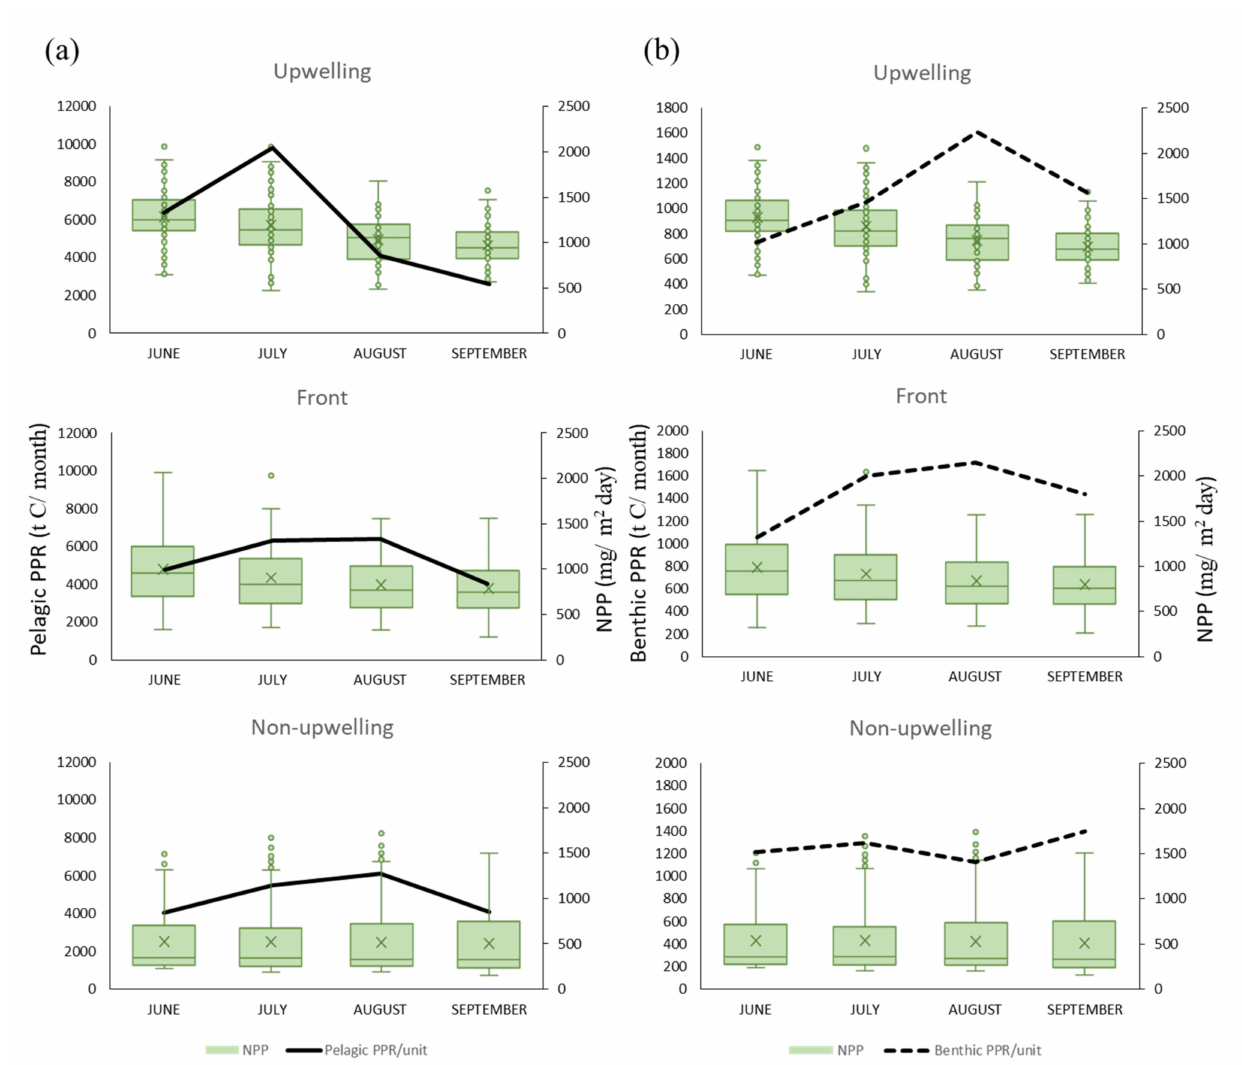
Figure 9. Effects of net primary production (NPP; monthly means) on ( a ) pelagic primary production required (PPR), and ( b ) benthic PPR in the three